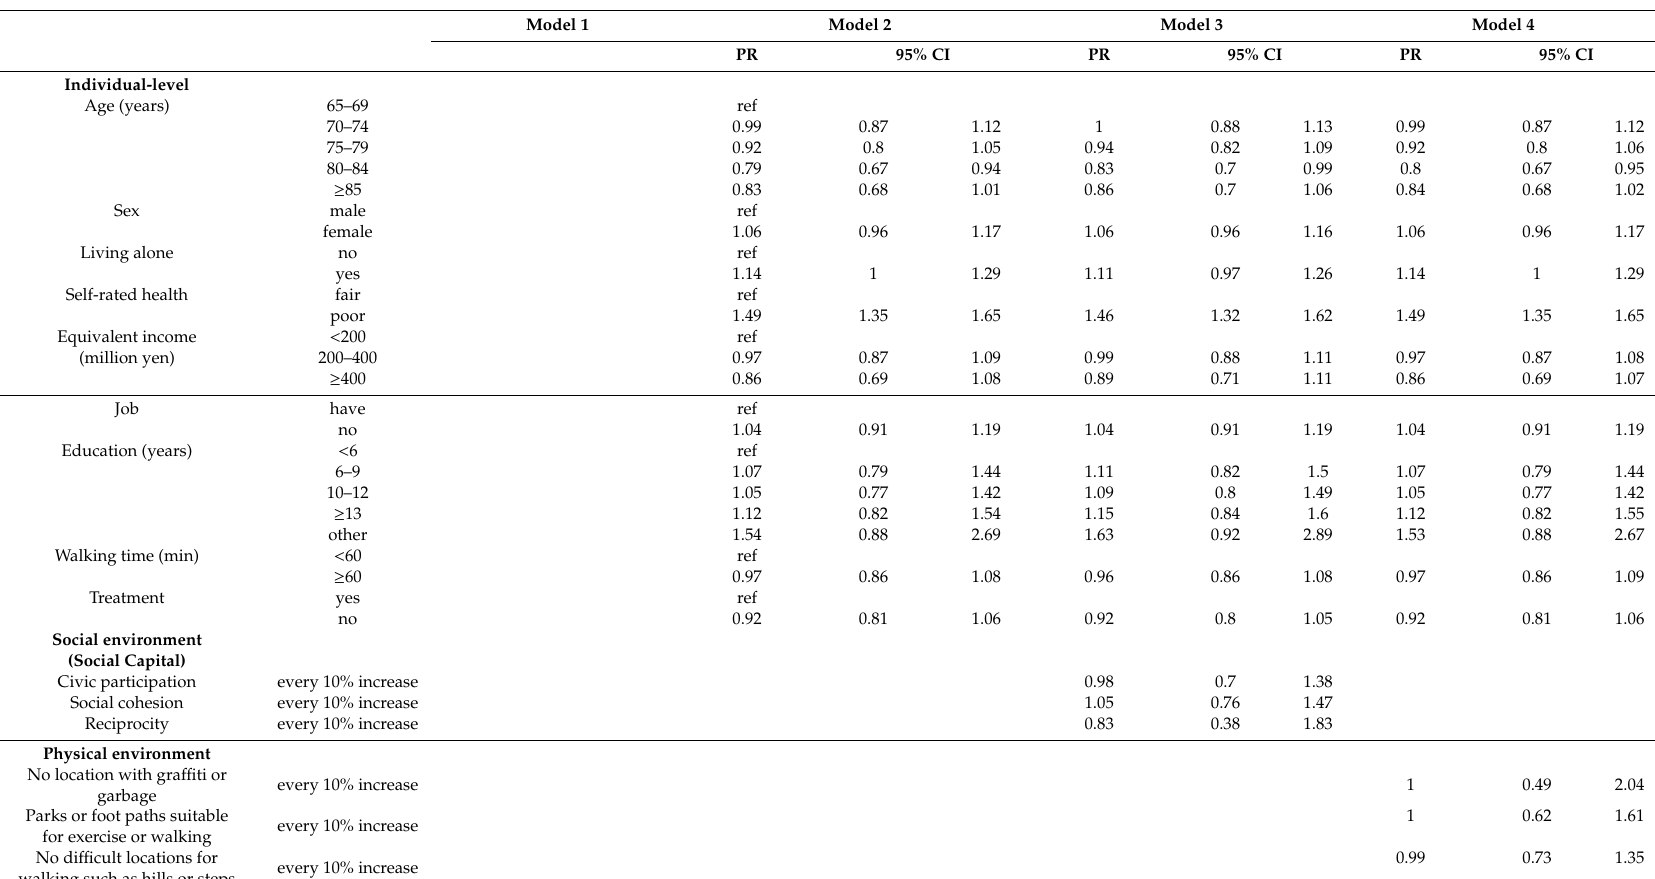
Table 5. Results of the multilevel Poisson regression analysis to study the association between neighborhood environment and sleep quality in depressive participants (Geriatric Depression Scale score of ≥